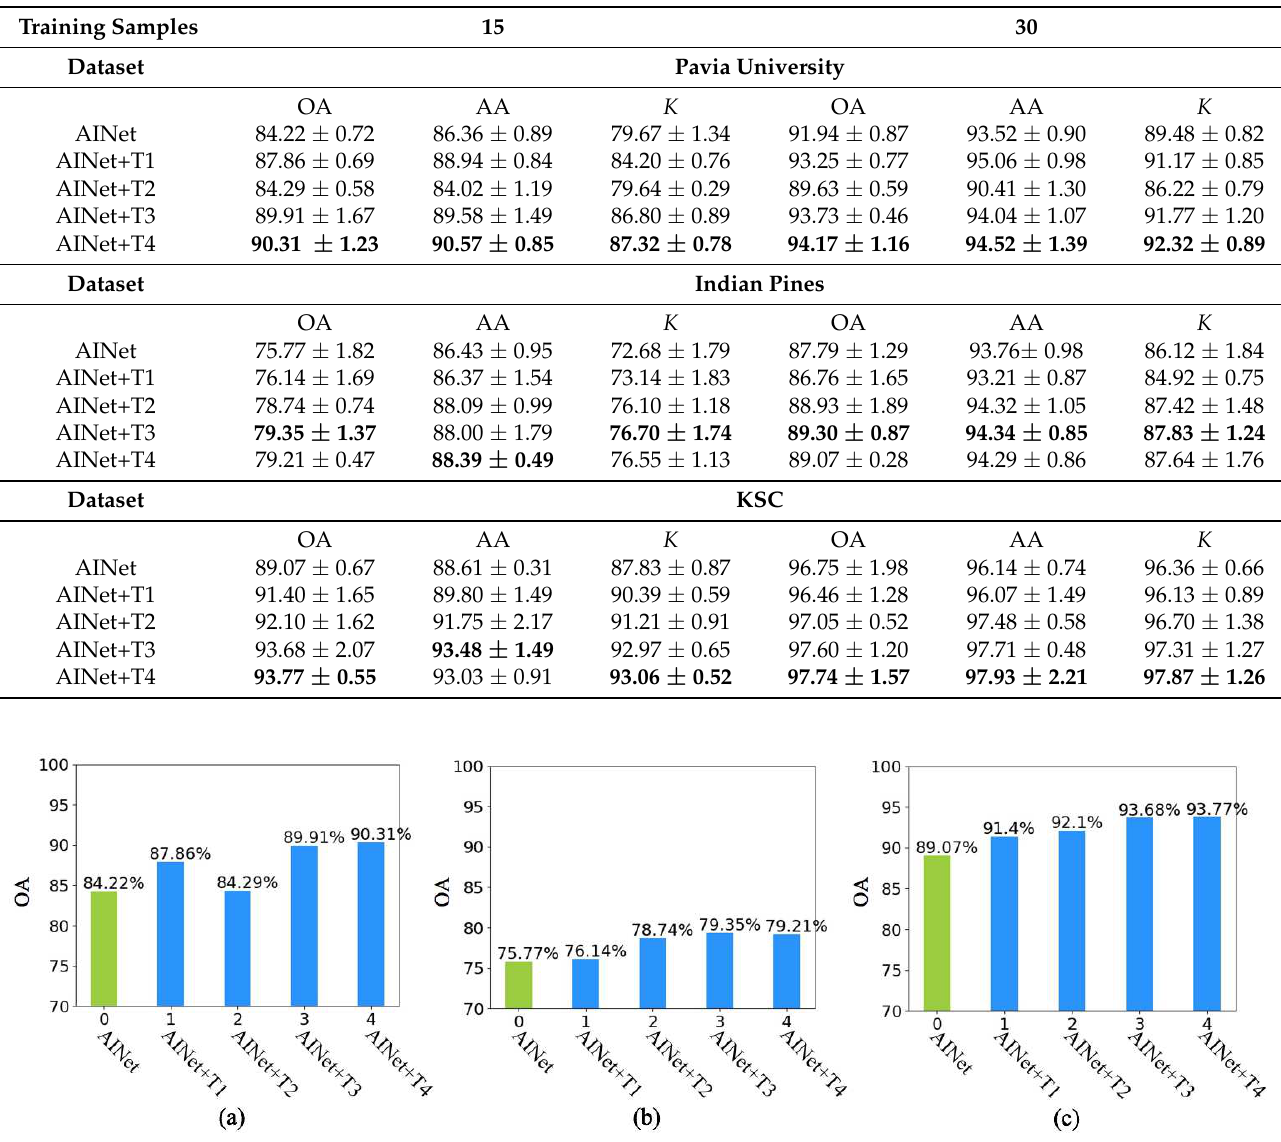
Figure 9. Transfer learning experiments with 15 training samples per class. ( a ) Pavia University; ( b ) Indian Pines; ( c ) Kennedy Space